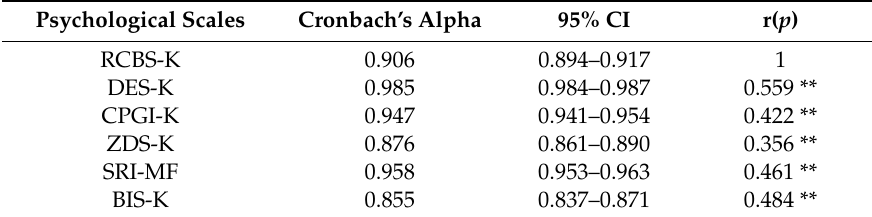
Table 4. Reliabilities and Correlation between RCBS-K and other psychological